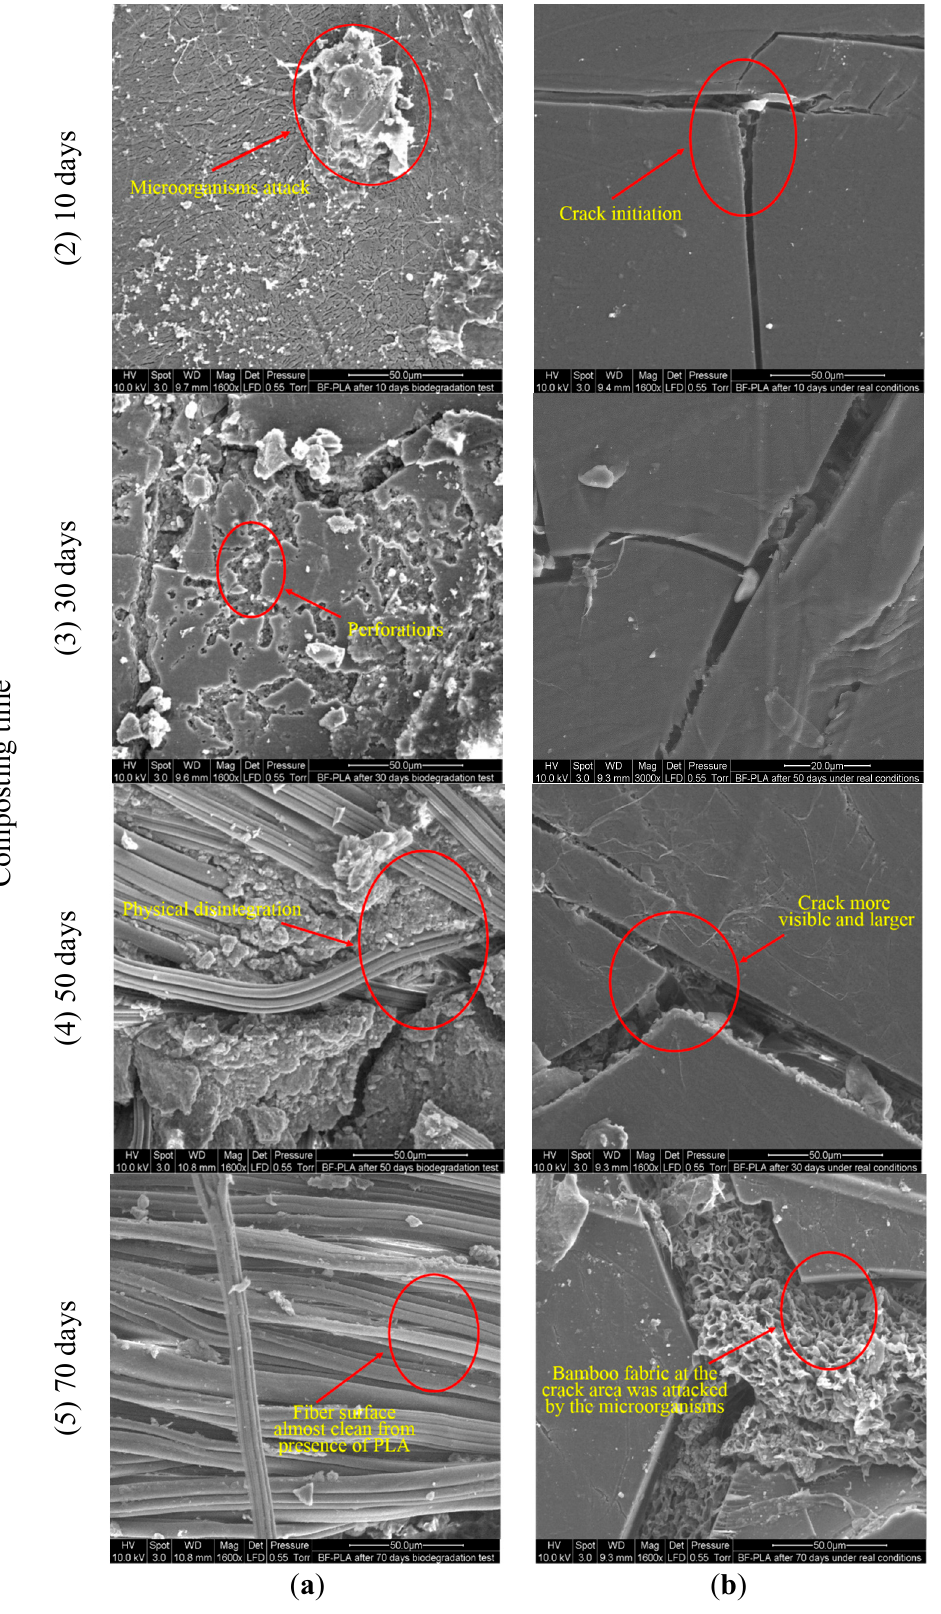
Figure 11. ESEM images of bamboo fabric-reinforced PLA composites in controlled composting condition ( a ) and real composting conditions ( b ).